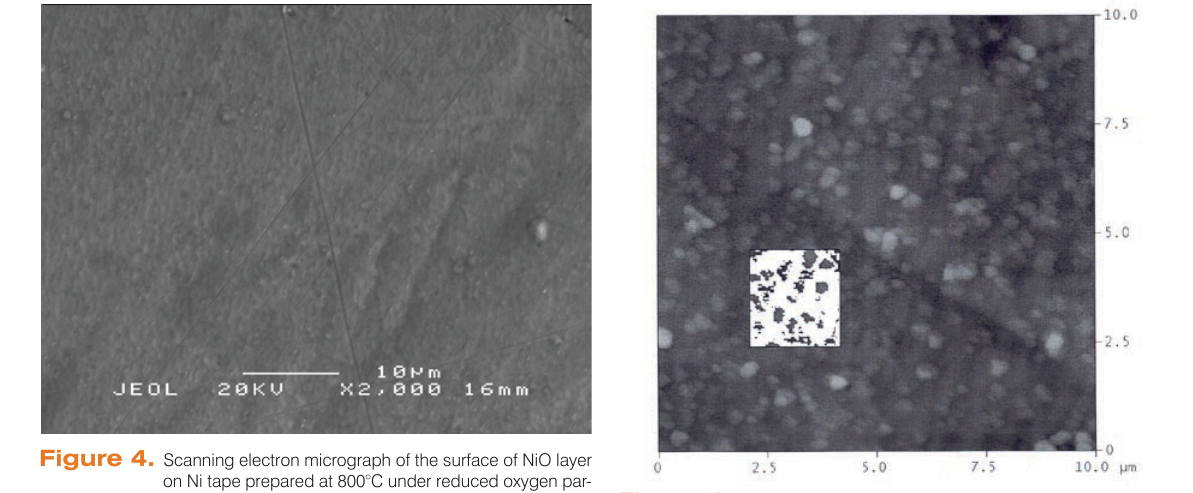
Figure 6. Two-dimensional atomic force microscopy image (10 µm x 10 µm) of a NiO buffer layer oxidized at 800°C.